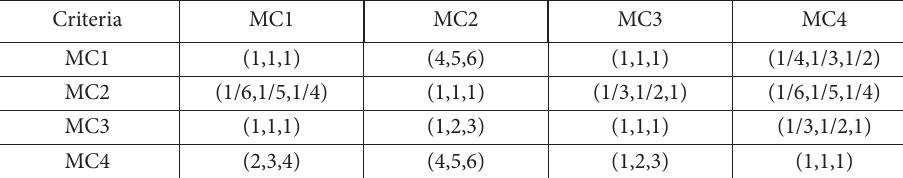
Table 3. Fuzzy comparison matrix for main criteria according to the goal